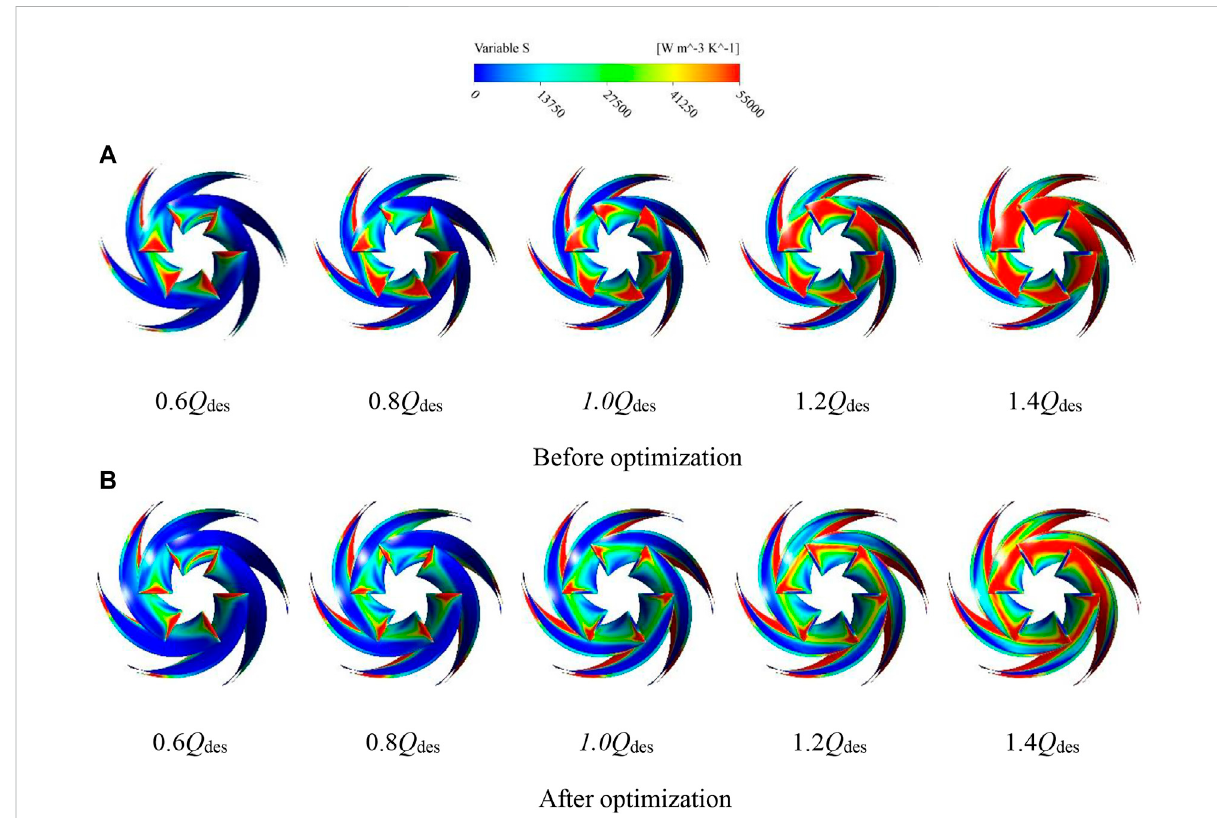
FIGURE 14 Distribution of blade entropy generation under different working conditions before and after optimization. (A) before optimization (B) after